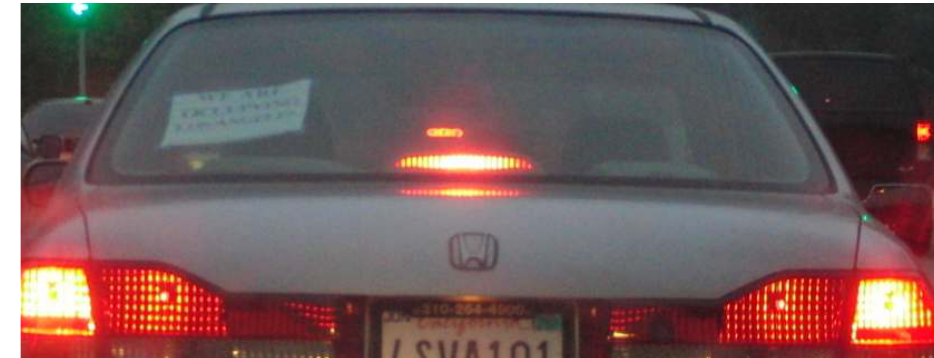
Figure 6: “Occupy” supporter in